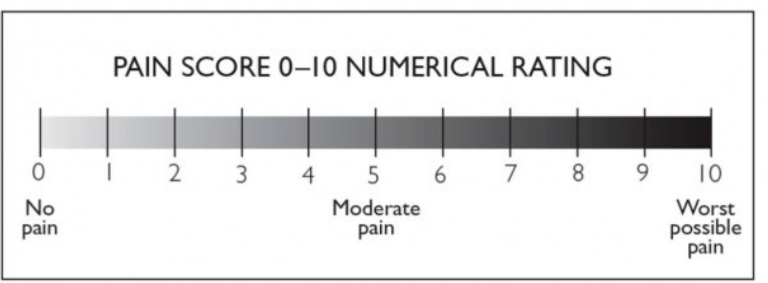
Figure 10. Numerical Pain Rating Scale (NPRS) indicating different intensities of pain: 0 means no pain, 5 reveals moderate pain, and 10 indicates severe pains.